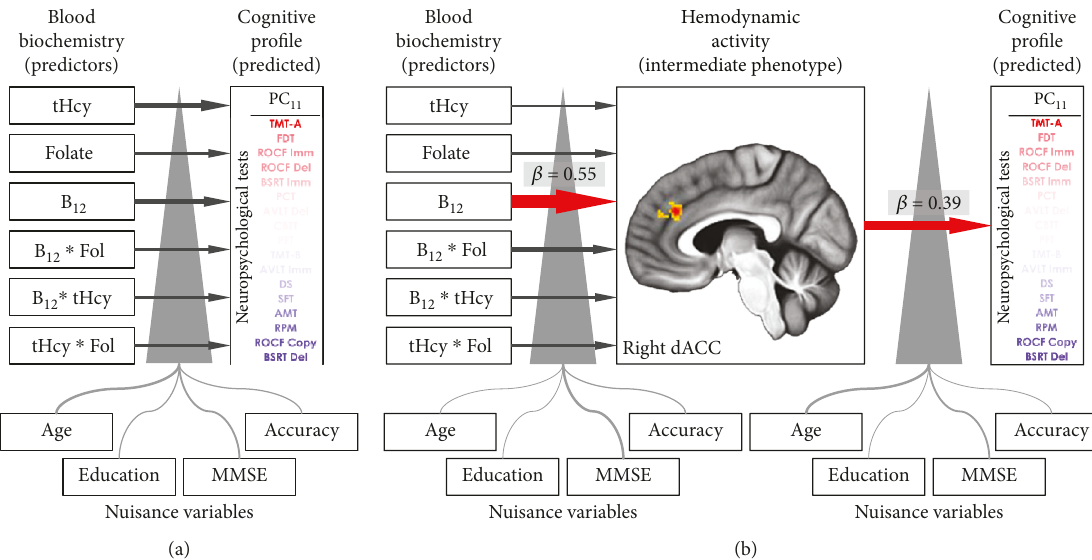
Figure 4: Resulting model for the relationship between blood biochemistry, right dACC activity, and cognitive pro fi les. (a) Scheme depicting the role of B , folate, tHcy, and their interactions, as direct predictors of the cognitive pro fi le expressed by the 11th component (PC). No 12 signi fi cant associations were found between biochemical markers and cognitive status. Loadings of each neuropsychological test for the 11th component are color coded: the more intense the red is, the more positive is the loading of a test; vice versa, the more intense the blue is, the more negative the loading. Age, years of education, Mini Mental State Examination scores, and fMRI task accuracy are included in the model as nuisance variables. (b) Activity of the right dACC signi fi cantly acts as an intermediate phenotype in linking B 12 serum levels to subjects ’ spatial attention and search abilities. Indeed, the right dACC hemodynamic activity correlated with B serum 12 levels ( β = 0 55 ) and predicted PC ( β = 0 39 ). Please note that B levels per se were not able to predict the same cognitive pro fi le. In 11 12 both panels, arrow thickness represents the strength of the association between variables. Signi fi cant relationships are marked with colored arrows (positive relationships red, negative blue). The same nuisance variables are included in the model at both steps of analysis. RPM: Raven ’ s Progressive Matrices; AVLT: Rey Auditory Verbal Learning Test; BSRT: Babcock Story Recall Test; DS: Forward Digit